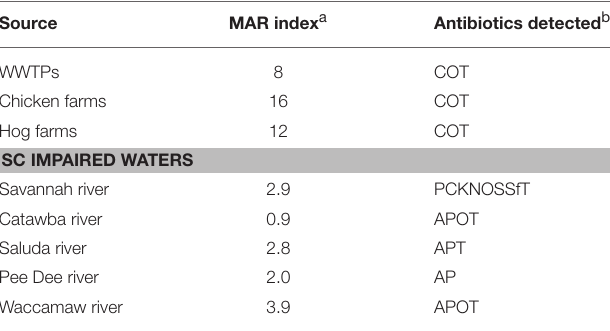
TABLE 3 | Impaired Watershed Study in South Carolina (SC) (National Oceanic and Atmospheric Administration,